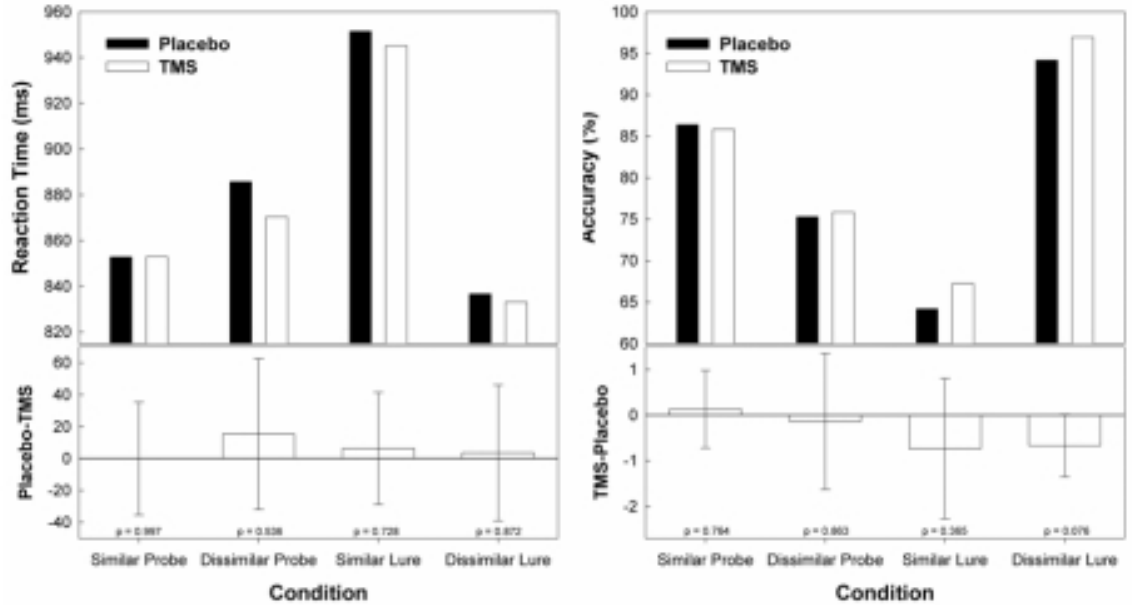
Fig. 4. Response time and accuracy plots for control stimulation, The left and right plots are analogous to the response time and accuracy plots in Fig. 3 for the control or parieto-occipital junction